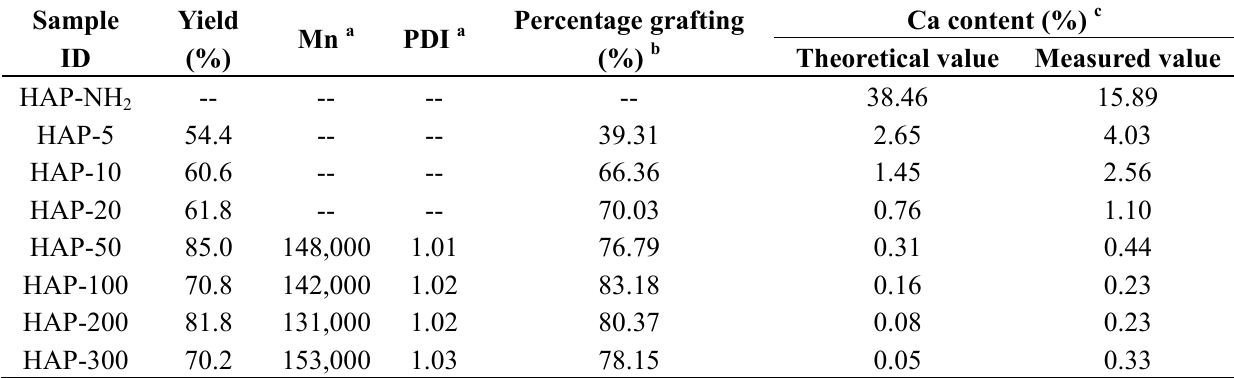
Table 1. The yield, Mn, PDI, percentage grafting, and Ca content of HAP-PBLG.